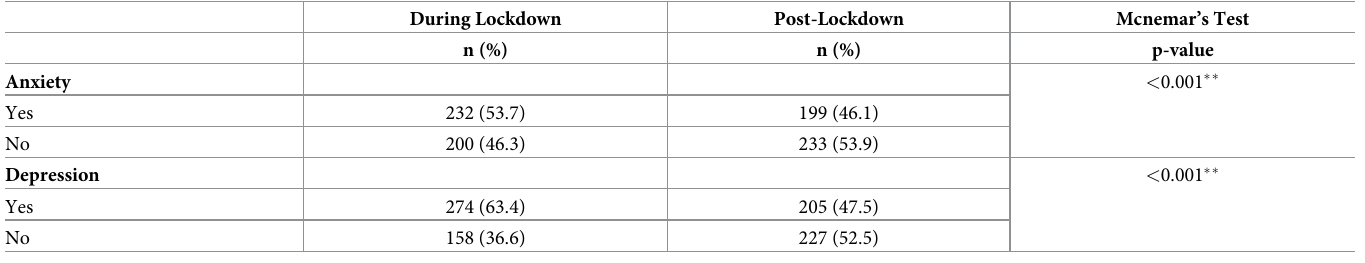
Table 2. Difference in anxiety, depression, and physical activity level before and after COVID-19 lockdown. During